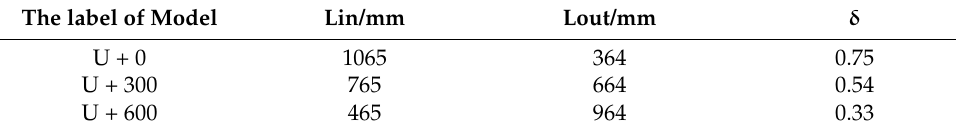
Table 1. Comparison of parameters of different models. The label of Model